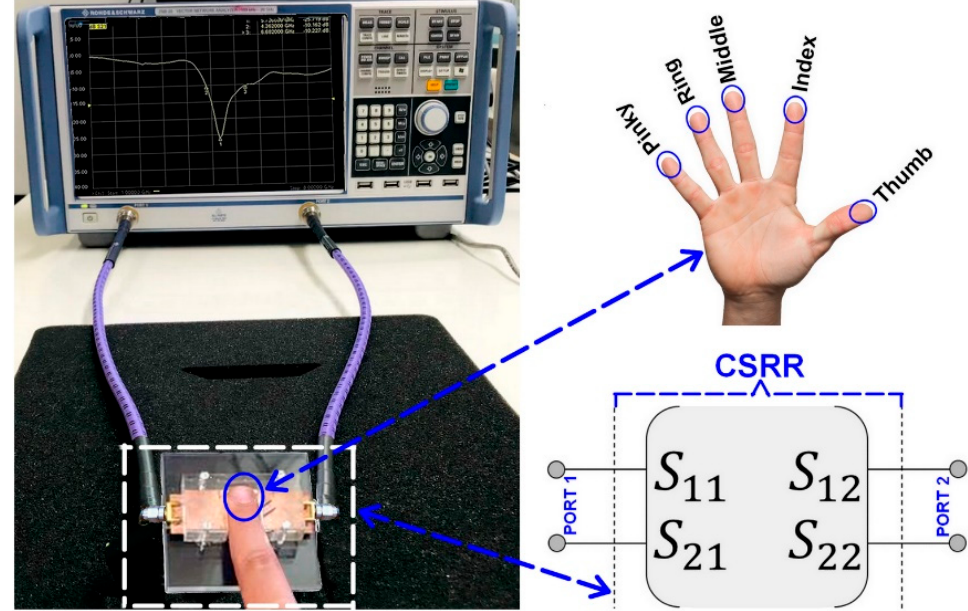
Figure 6. Setup for S-parameter measurement of the manufactured CSRR sensor when loaded with the fingertips of a healthy participant in adult age.